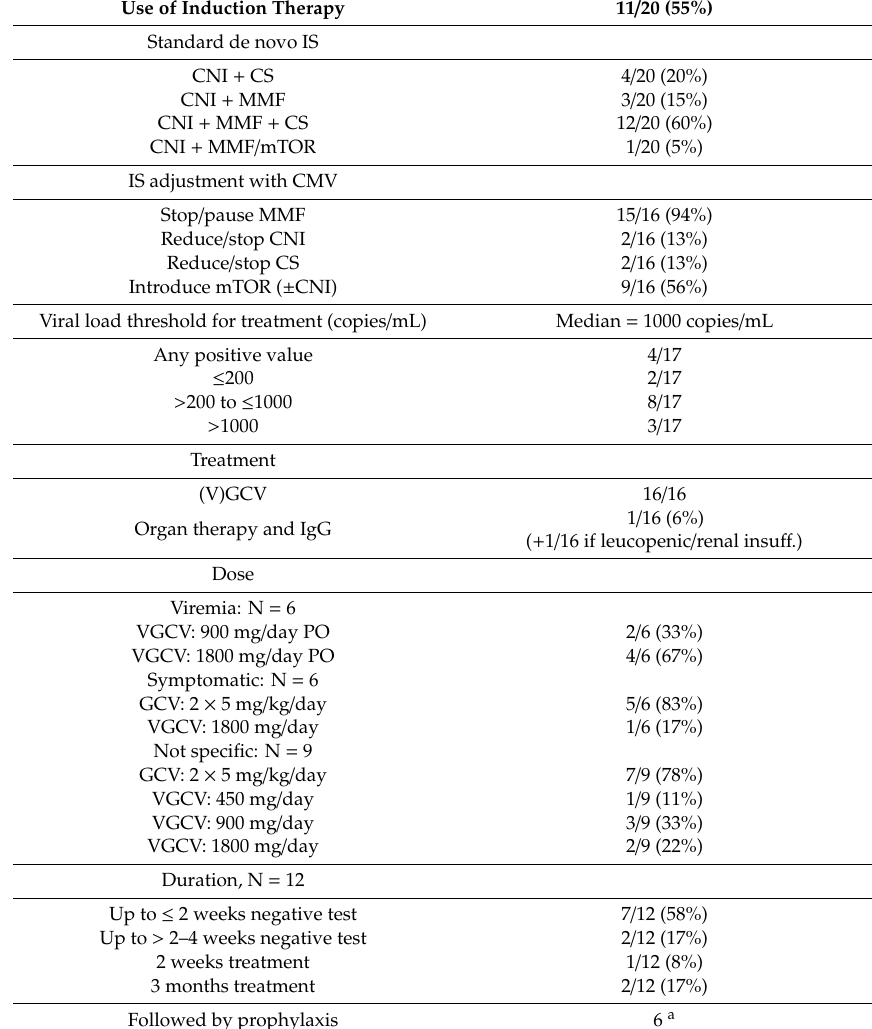
Table 2. Current approaches in German transplant centers to immune suppression and human cytomegalovirus (CMV) treatment in liver transplant recipients with CMV disease. Use of Induction Therapy 11 / 20